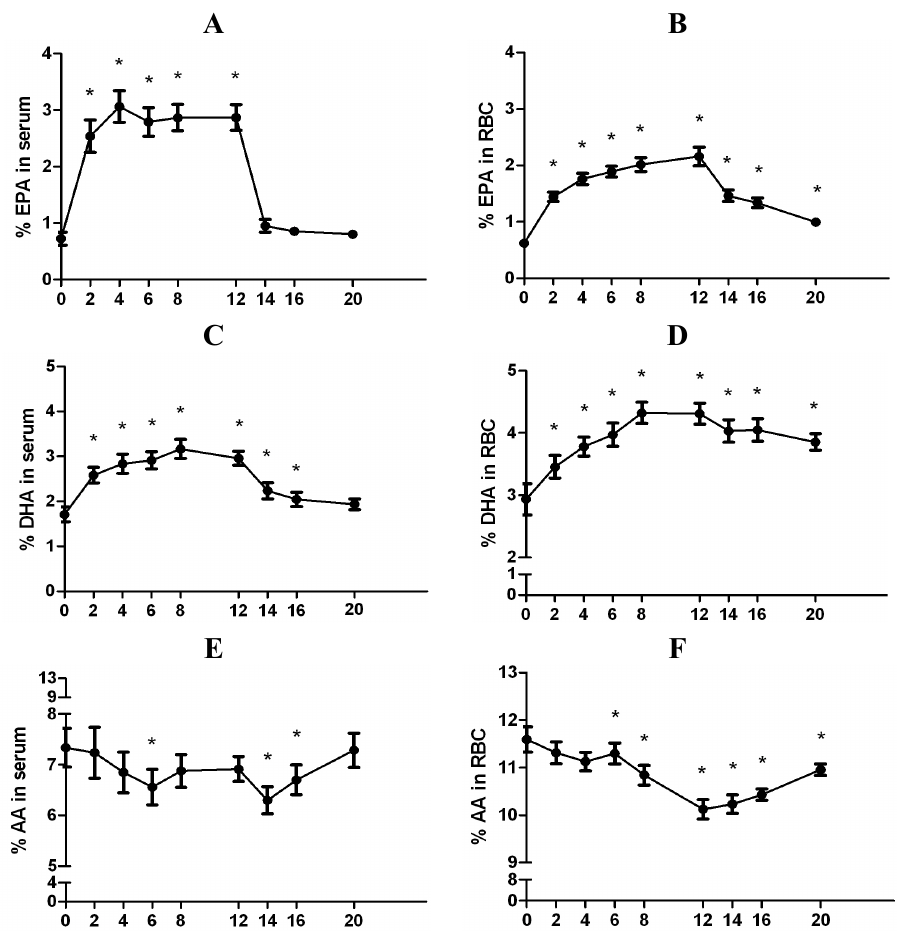
Figure 2. Levels of eicosapentaenoic acid (EPA), docosahexaenoic acid (DHA), and arachidonic acid (AA) in serum and RBCs. Relative % EPA in ( A ) serum and ( B ) RBCs. Relative % DHA in ( C ) serum and ( D ) RBCs. Relative % AA in ( E ) serum and ( F ) RBCs. FAs are represented as relative % of total FA values. Numbers on the x -axis represent time in weeks, where baseline is indicated by 0. * Indicates p < 0.05 compared to baseline